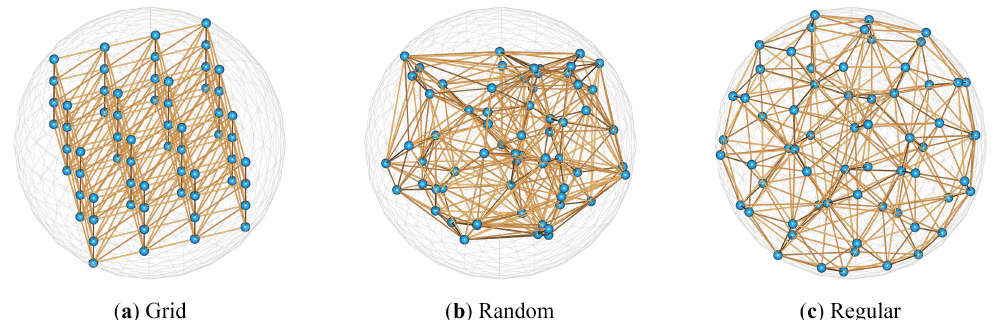
Figure 9. Illustration of three different distributions of 64 sample positions (blue dots). The orange edges in this figure are derived from the Delaunay triangulation of the sample positions, which are intended for visualization purposes.